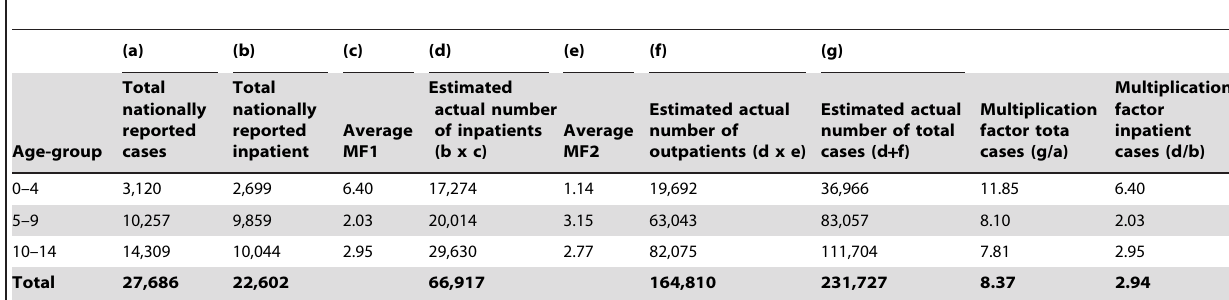
Table 2. Median reported dengue cases and application of age-group specific multiplication factors (MF), Thailand 2003–2007.